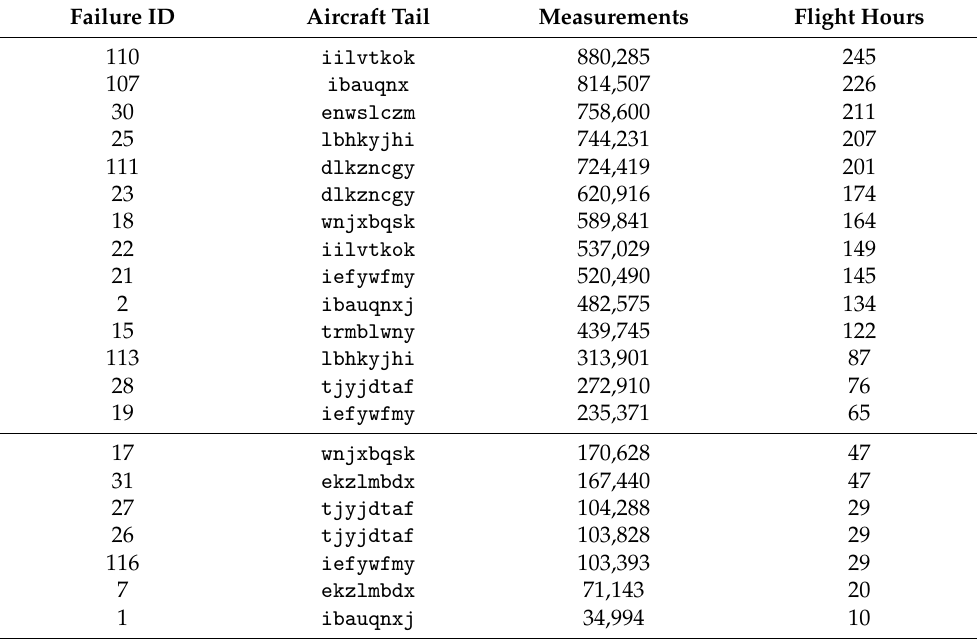
Table 1. CU Trajectories by Failure